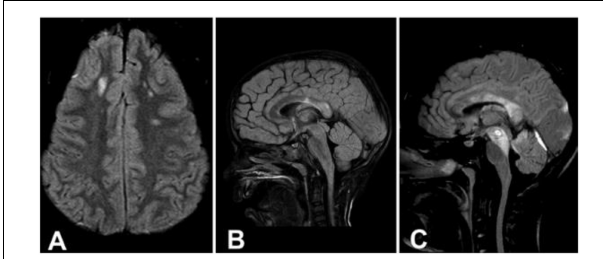
FIGURE 2 | (A) Axial image demonstrating signal intensity changes in the lobar white matter (Stage 1). (B) Sagittal image demonstrating signal intensity changes in the splenium of the corpus callosum (Stage 2). (C) Sagittal image demonstrating signal intensity changes in the rostral brainstem (Stage 3). Reproduced with permission from Skandsen et al.